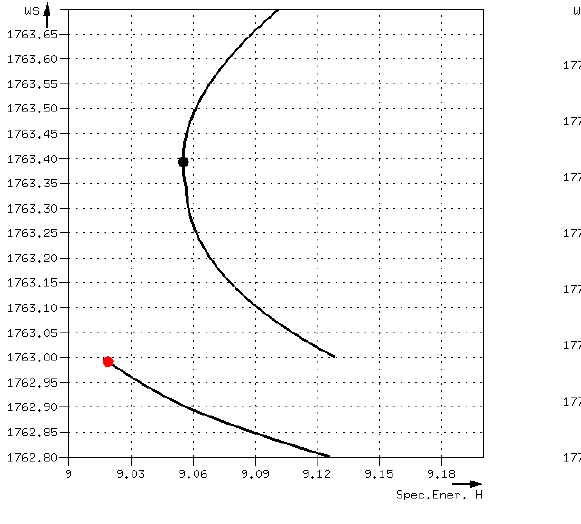
Figure 17 . Dataset 3: Critical depths of case 5 ( a ) section 9 and ( b ) section 27